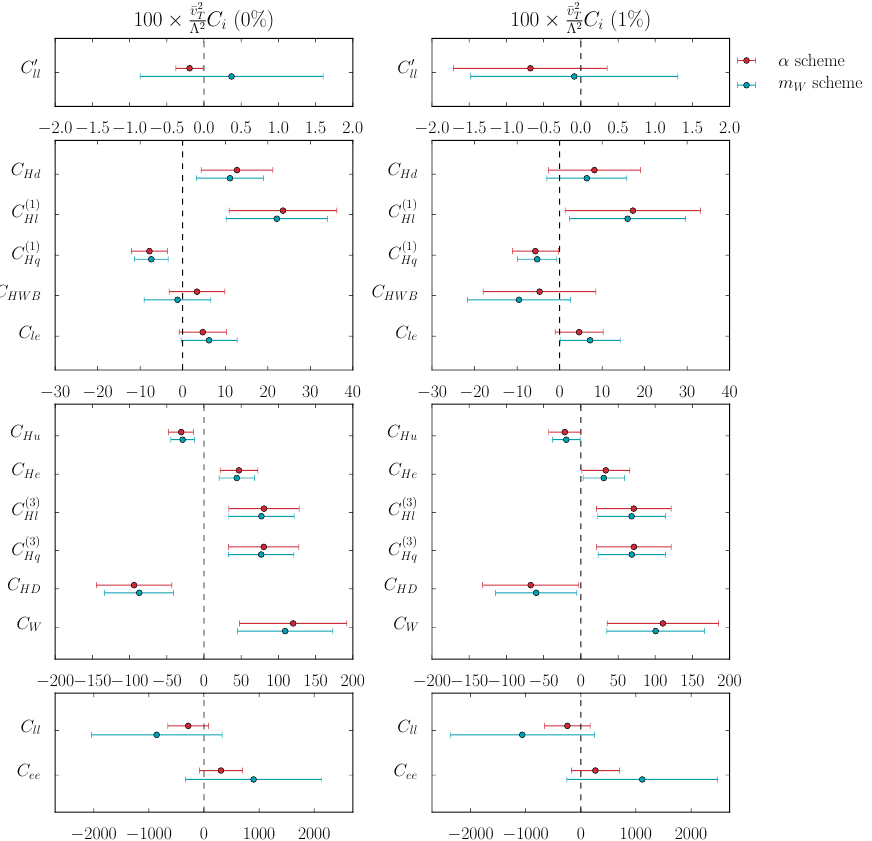
Figure 3 . Best (cid:12)t values of the Wilson coe(cid:14)cients (scaled by a factor 100) and corresponding 1 (cid:27) con(cid:12)dence regions obtained after pro(cid:12)ling away the other parameters. Red (blue) points were (cid:6) obtained in the ^ (cid:11) ( ^ m W ) ; ^ m Z ; ^ G F input parameter scheme. The plot to the left has been obtained f g assuming (cid:1) SMEFT = 0, while the one to the right includes a theoretical error (cid:1) SMEFT = 0 : 01.